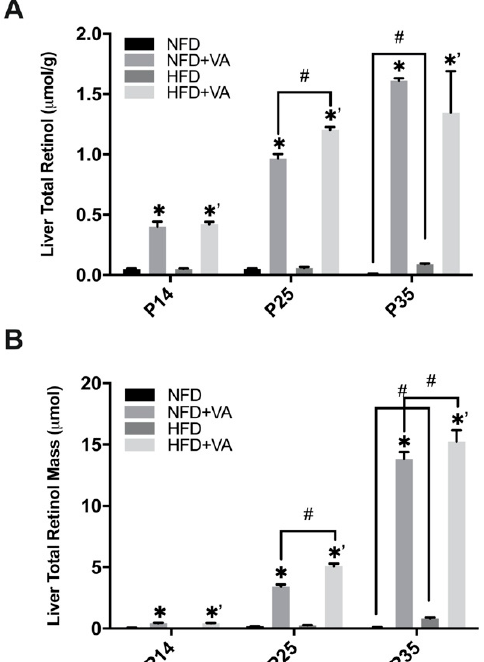
Figure 2. Liver total retinol concentration ( A ) and mass ( B ) of rat pups. Bars show mean ± SEM, n = 4 or 3 per group. Significant difference, p < 0.05, between NFD and NFD+VA was indicated by *, between HFD and HFD+VA by * ’ , and between NFD and HFD or between NFD+VA and HFD+VA by #. P14, postnatal day 14; P25, postnatal day 25; P35, postnatal day 35; NFD, normal fat diet; HFD, high fat diet; VA, vitamin A.